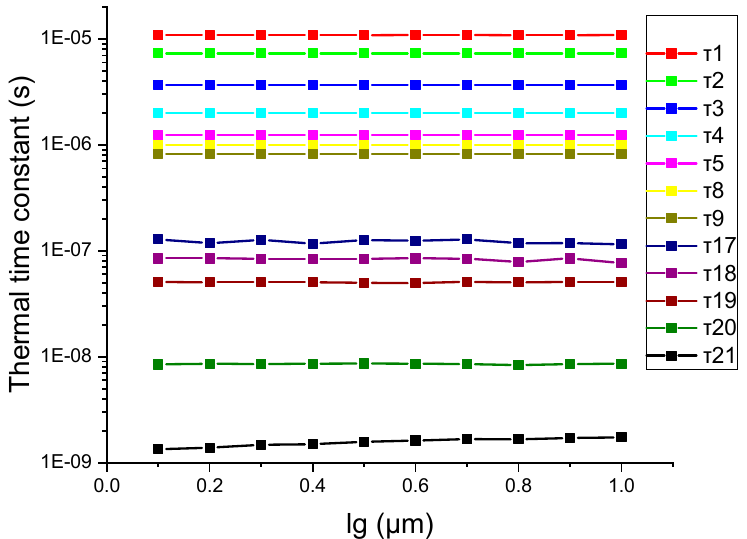
10 of 14 Figure 11. Thermal time constant spectrum for 2-D structure using MOR in black and Bagnall equa- tion in red. From the previous observations, complementary 2-D studies were performed for a heating region length “lg” varying from 0.1 µm to 1 µm.